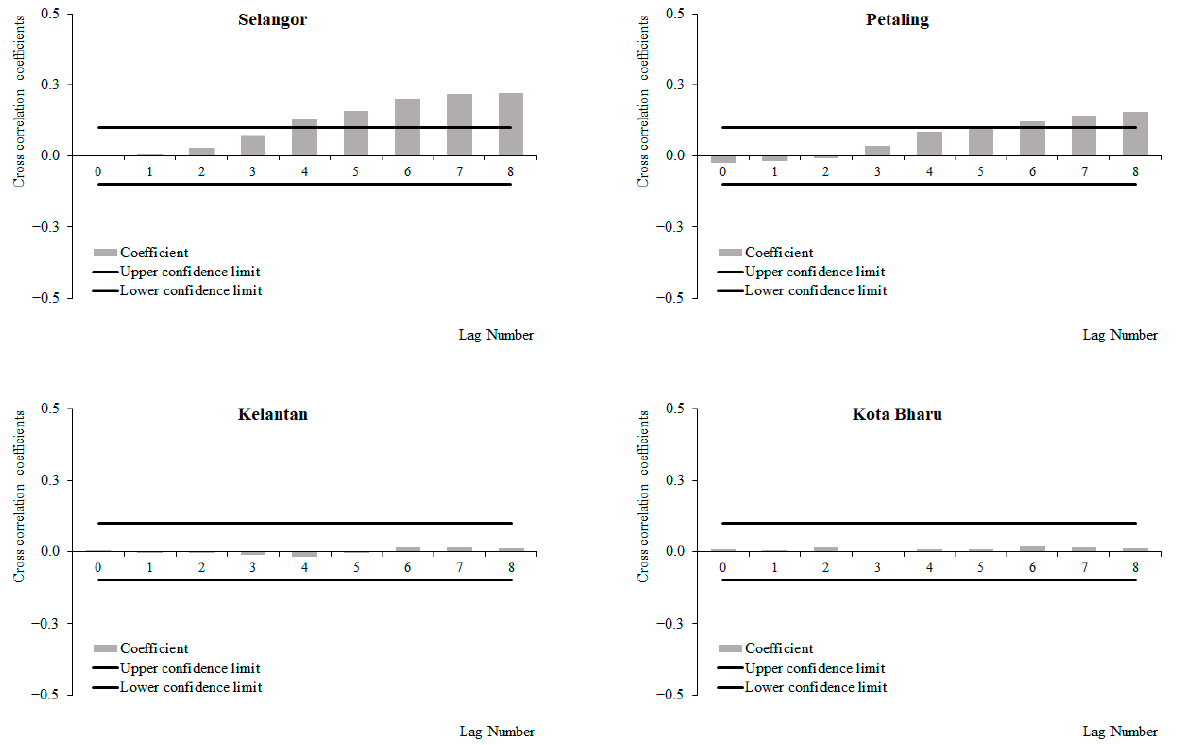
Figure 6. Cross-correlation function between dengue cases and rainfall in Selangor, Petaling, Kelantan and Kota Baharu, 2011 to 2019.